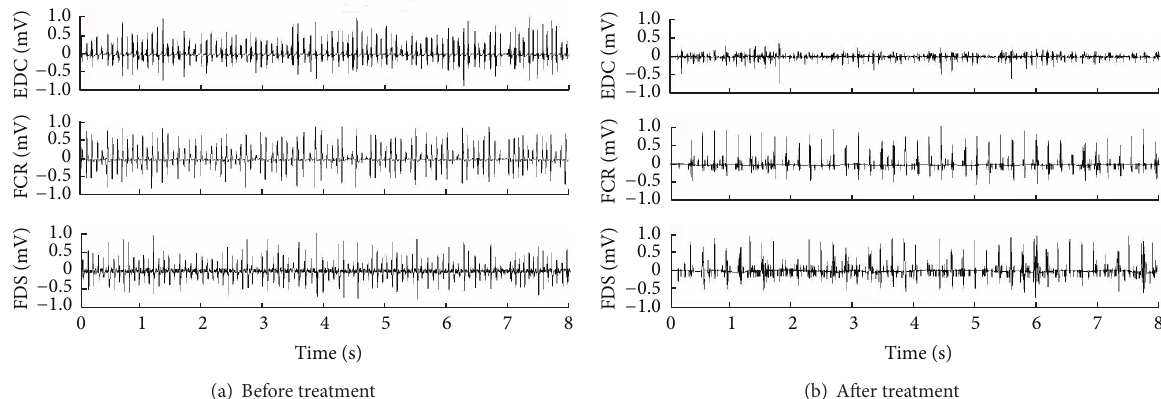
Figure 1: Surface EMG at rest (a) before treatment with botulinum toxin A and (b) 10 months after treatment. EDC: extensor digitorum communis; FCR: flexor carpi radialis; FDS: flexor digitorum